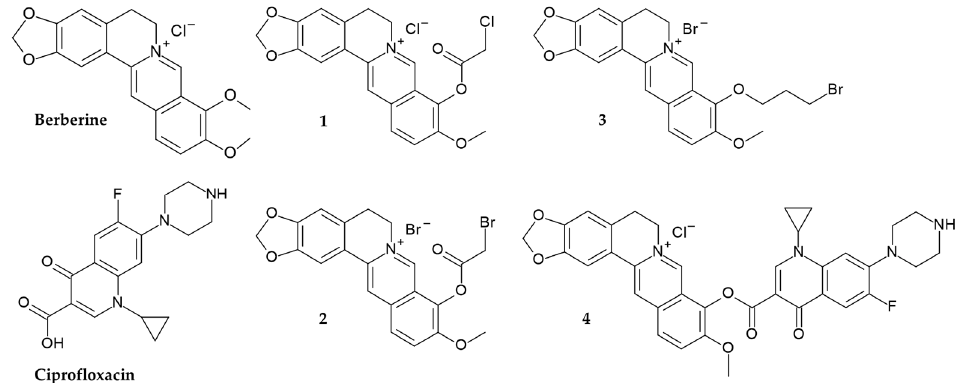
Figure 1. Chemical structures of berberine, ciprofloxacin and newly synthesized berberine derivatives.